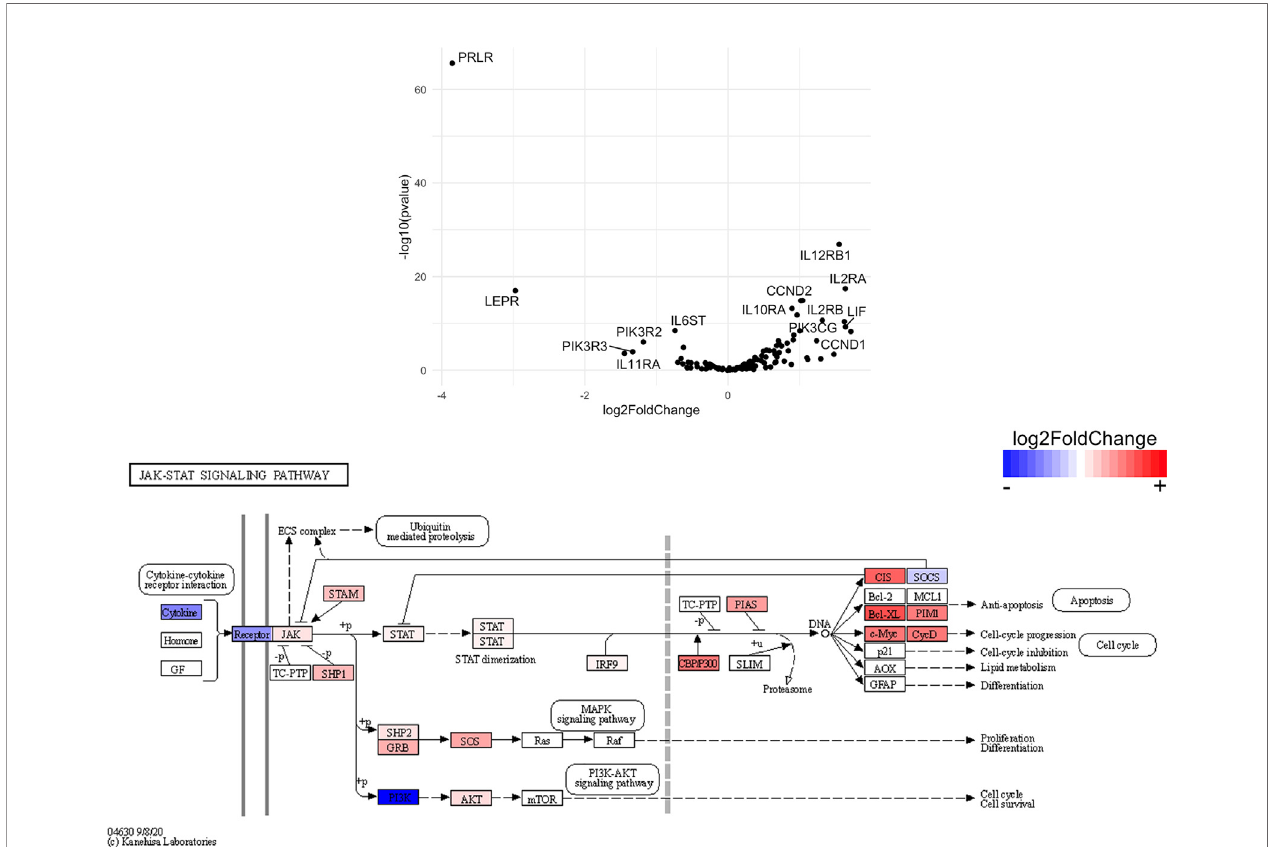
FIGURE 13 | Genes related to JAK/STAT signaling are enriched in CD8 + T cells from the CNS of microglia-de fi cient B6J mice compared to microglia-de fi cient SJL mice. C57BL/6J and SJL/J mice were treated with a PLX5622-supplemented diet seven days prior to i.c. TMEV infection and sacri fi ced at 6 DPI for analysis (n = 10 mice per group). Volcano plot of RNA-seq transcriptome data and KEGG map display JAK/STAT signaling-related gene expression in enriched CD8 + T cells from the CNS of microglia-de fi cient C57BL/6J mice relative to microglia-de fi cient SJL/J